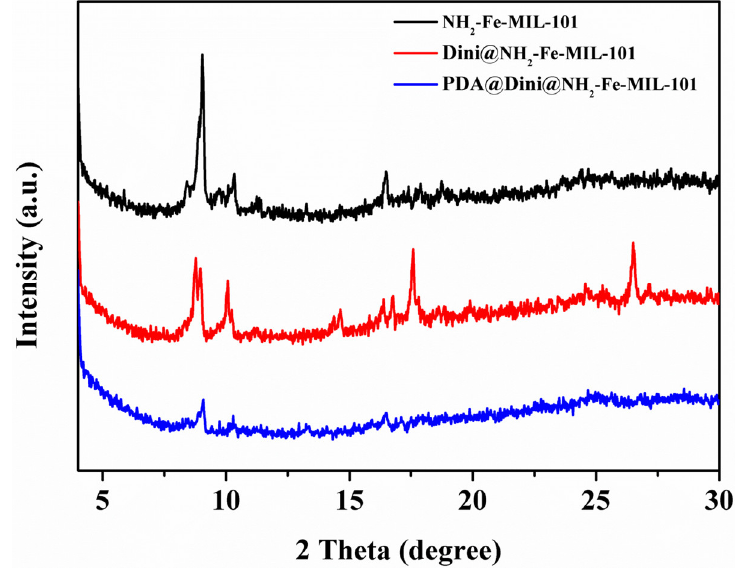
Figure 3. XRD pattern of NH 2 -Fe-MIL-101.